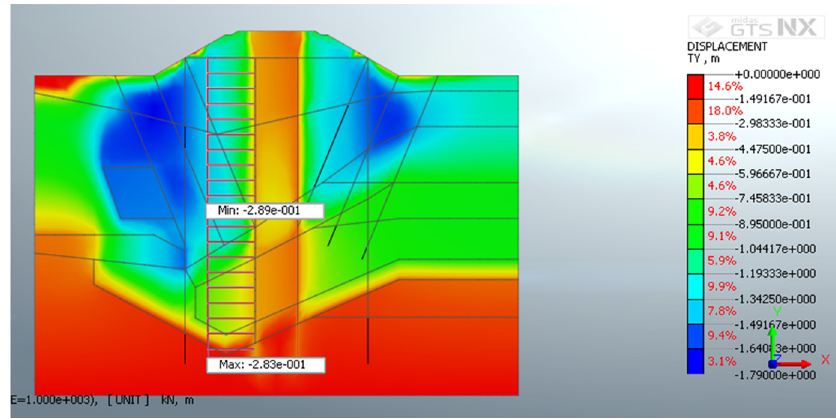
Figure 14: Vertical displacements map after strengthening with palisades on both sides and piles placed in the centre.